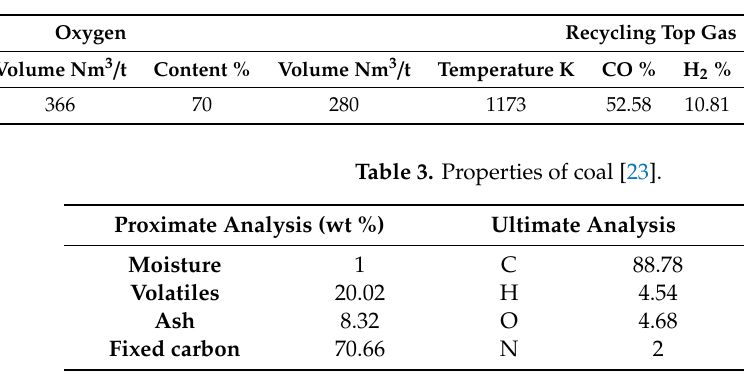
Table 2. Main blast parameters of TGR-OBF.